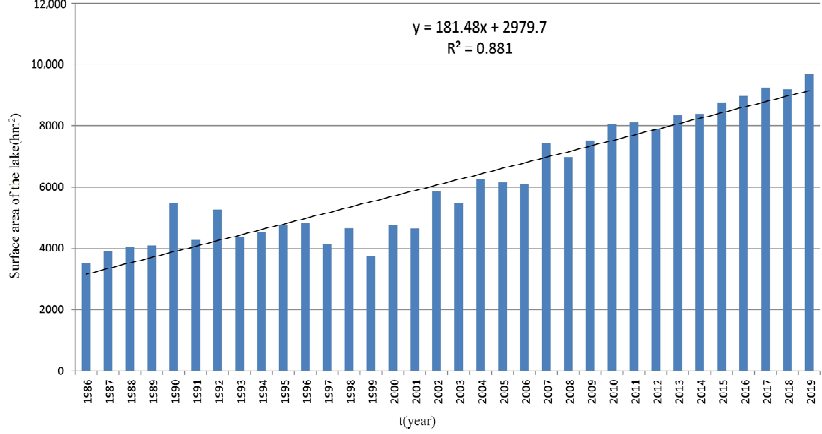
Figure 2. Changes of lake surface area in northern